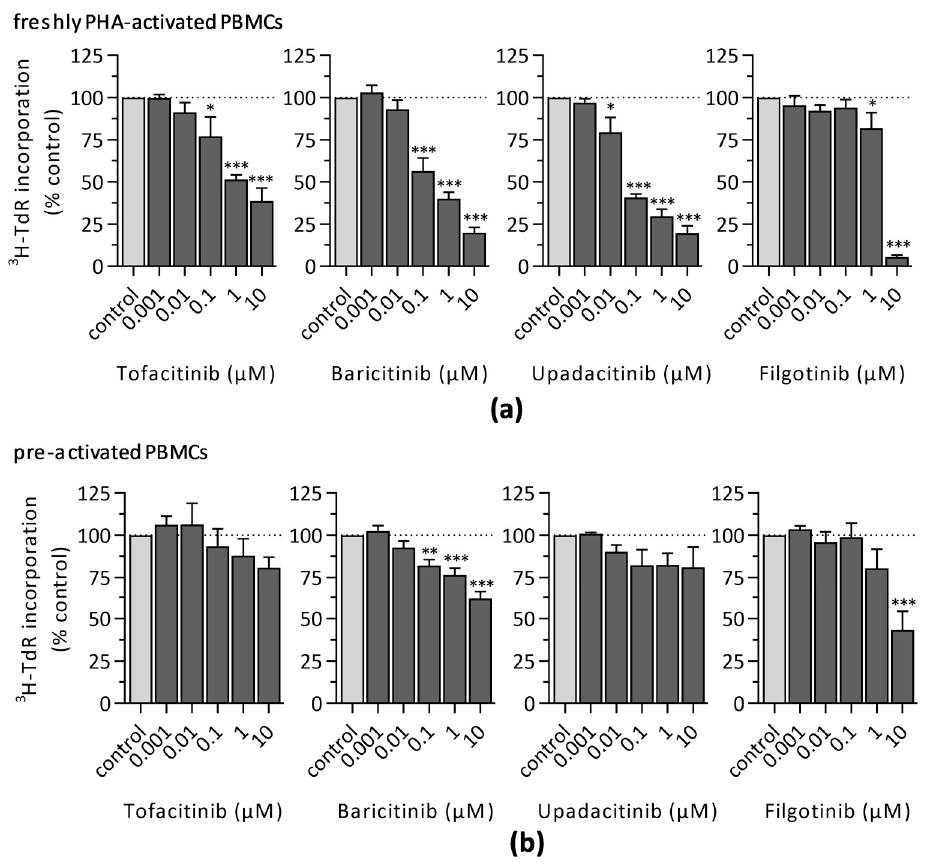
Figure 1. Proliferation analysis by 3 H-thymidine incorporation assay 72 h after PHA-stimulation of PBMCs treated with indicated concentrations of JAKi either ( a ) immediately after activation or ( b ) 48 h after PHA-stimulation. Diagrams display the mean ± SEM of five independent experiments normalized to the DMSO control (*** p ≤ 0.001; ** p ≤ 0.01; * p ≤ 0.05).